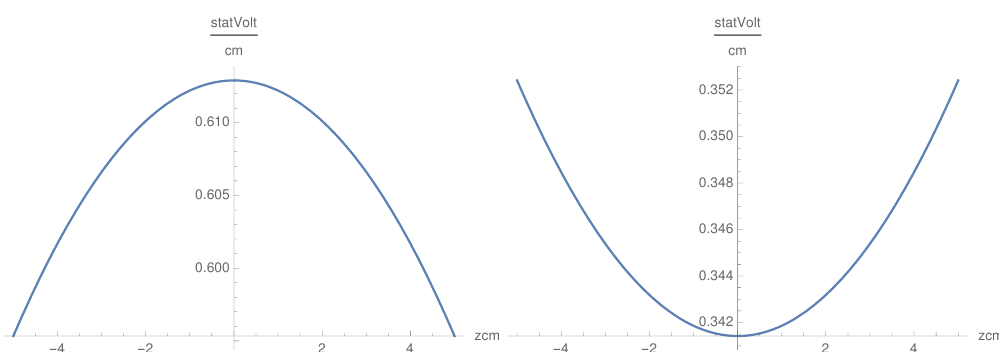
Figure 9. E x ( x , z , ω ) as a function of z for some values of x and ω : ω = 2 × 10 9 Hz and x = 2 cm ( left ), and ω = 2 × 10 9 Hz and x = 3 cm ( right